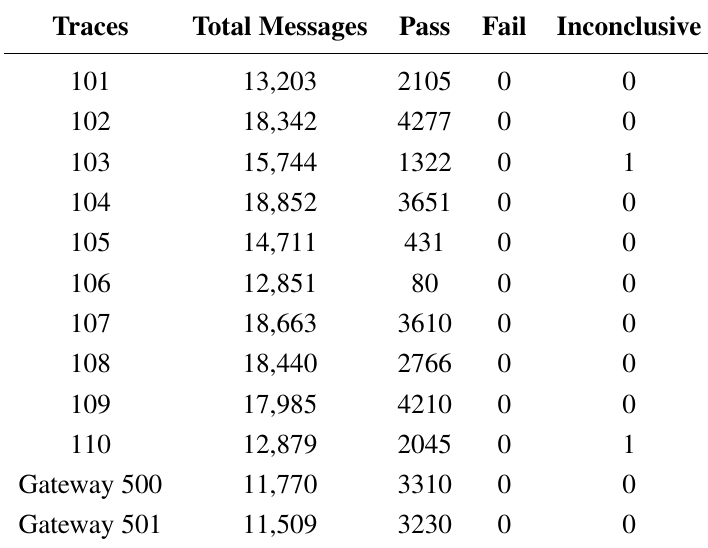
Table 5. Test results for Property 3 (Day